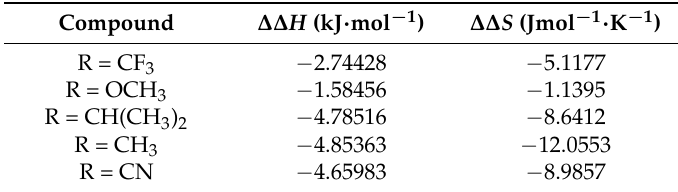
Table 6. Values of ∆∆ H and ∆∆ S .